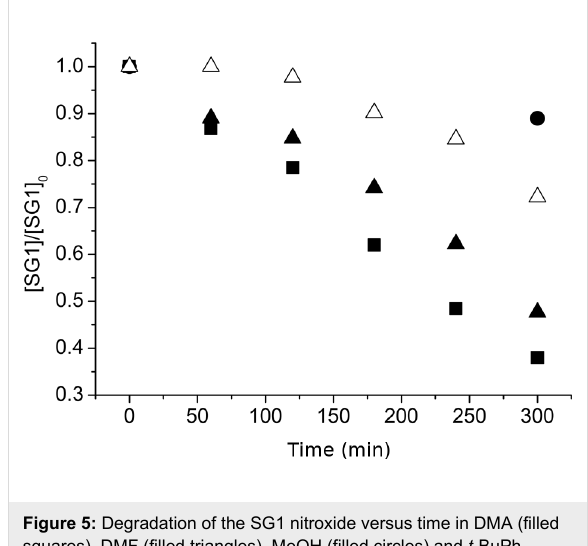
Figure 5: Degradation of the SG1 nitroxide versus time in DMA (filled squares), DMF (filled triangles), MeOH (filled circles) and t -BuPh (empty triangles) as measured by ESR in t -BuPh at 25 °C (samples heated in DMA, DMF, MeOH or t -BuPh at 120 °C, removed after 1 to 5 hours and diluted in t